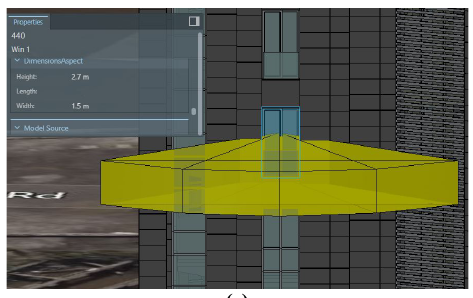
(c) Figure 9 . Modelled overlooking LuR for a window with a (b) Figure 10 . Detected height limits conflicts (coloured in red) with a) a full view and b) a zoomed view in which the conflicts got filtered.